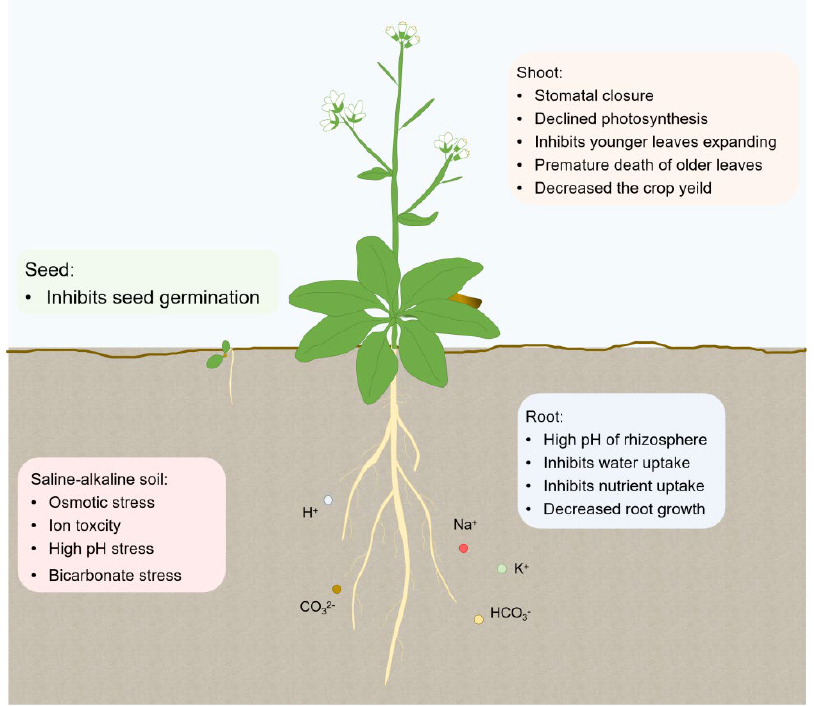
Figure 1. The effects of saline-alkali stress on the growth and development of plants. Saline-alkali stress induced osmotic stress, ion toxicity, high pH stress, and HCO 3 − /CO 32 − stress, which affect seed germination, disturb the pH of the rhizosphere, inhibit the absorption of water and nutrients in the root, leading to the decreased root growth. Meanwhile, osmotic stress affects stomatal closure, inhibits the expansion of younger leaves and accelerates the senescence of leaves, ultimately resulting in repressed photosynthesis and low crop yield.